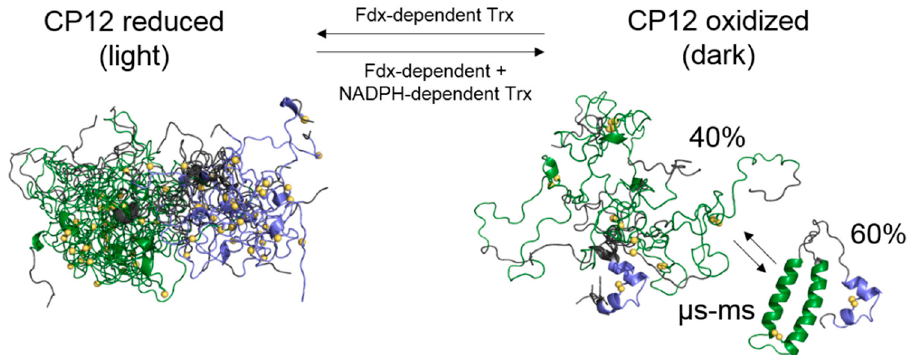
Figure 1. Model of the redox-transition of CP12. The structural models are derived from Launay et al. [30,31]. The complex Trx network is derived from Cejudo et al. [15]. The sulphur atoms of the two pairs of cysteine residues are in yellow. Trx and Fdx stand for thioredoxins and ferredoxin, respectively.